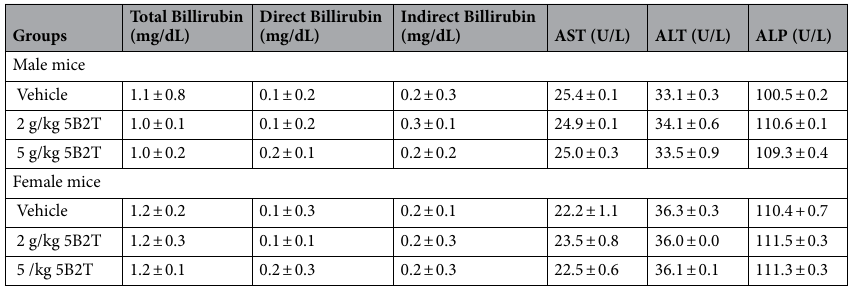
Table 2. Liver function test of experimental mice treated with high doses of 5B2T. Values expressed as mean ± S.E.M. There are no significant differences between groups. Significant value at p < 0.05.